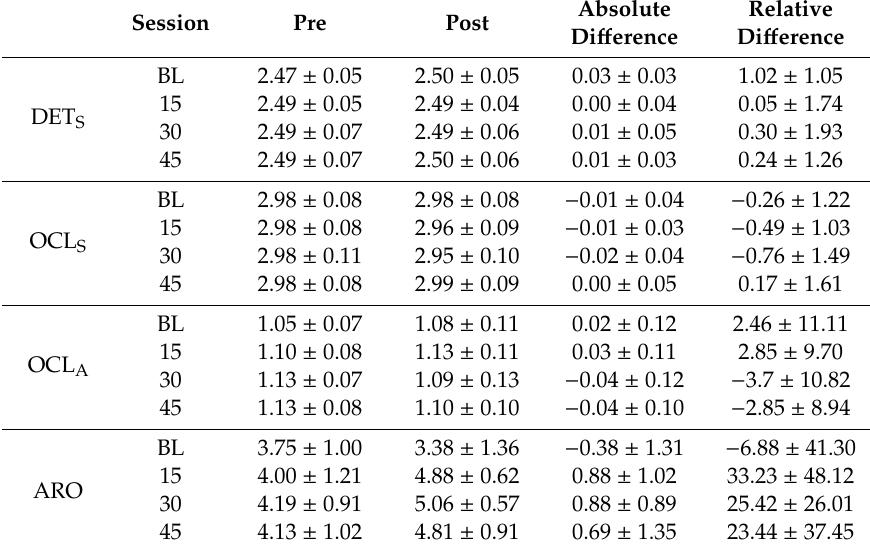
Figure 1. Means and 95% confidence intervals of changes in self-perceived state of arousal after aerobic exercise. Table 3. Cognitive test performance and subjectively perceived arousal across all four experimental sessions (mean ± SD).